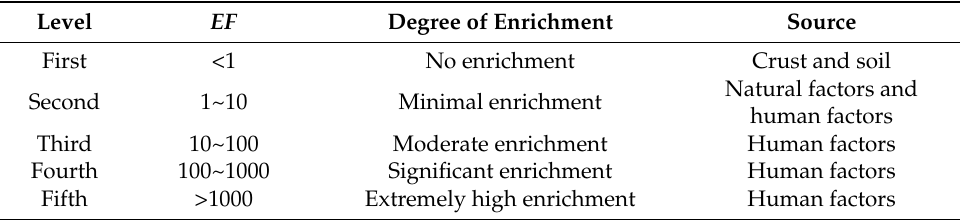
Table 1. The standard of enrichment